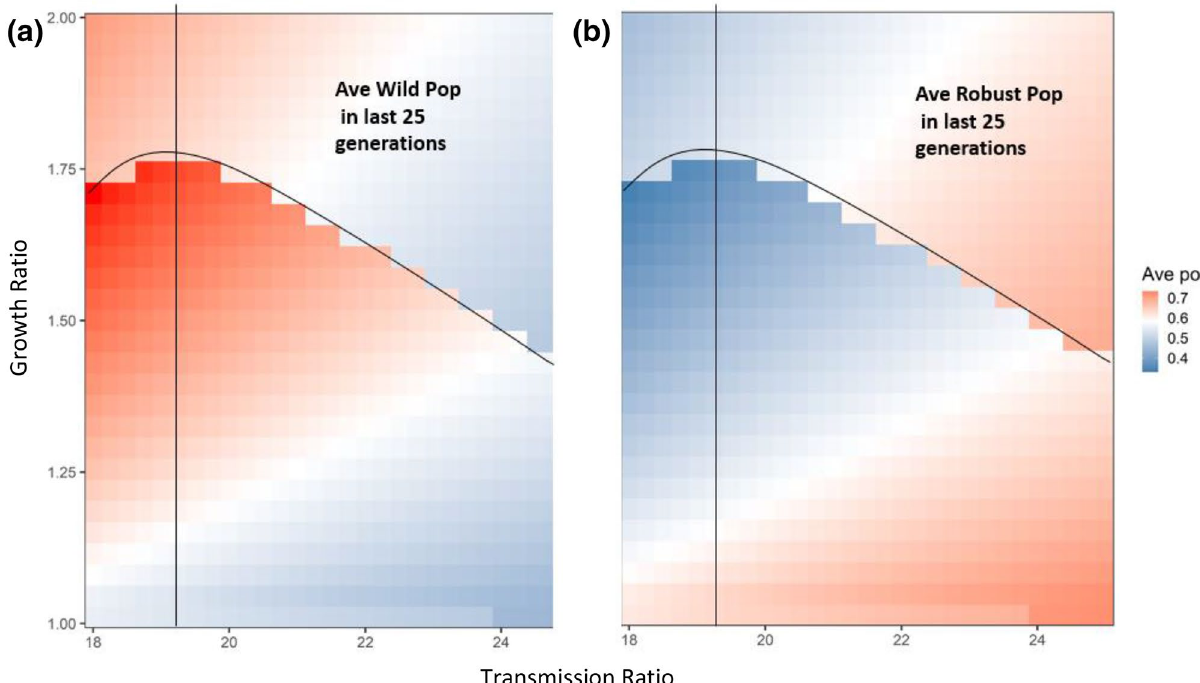
Figure 2. The standardized average population size (population size divided by carrying capacity) of both wild type ( a ) and robust type ( b ) in the last 25 generations (total simulated generations are 50) under the influences of transmission ratio and growth ratio at patch #30, where robust type provides the baseline growth rate and transmission rate. The color trend represents the average population size: from blue to white to red, average population sizes increase. All the other parameters are: r R = 0.15, r Wd = r Rd = 0.01, r Wr = r Rr = 0.2, α W = α R = 0.05,